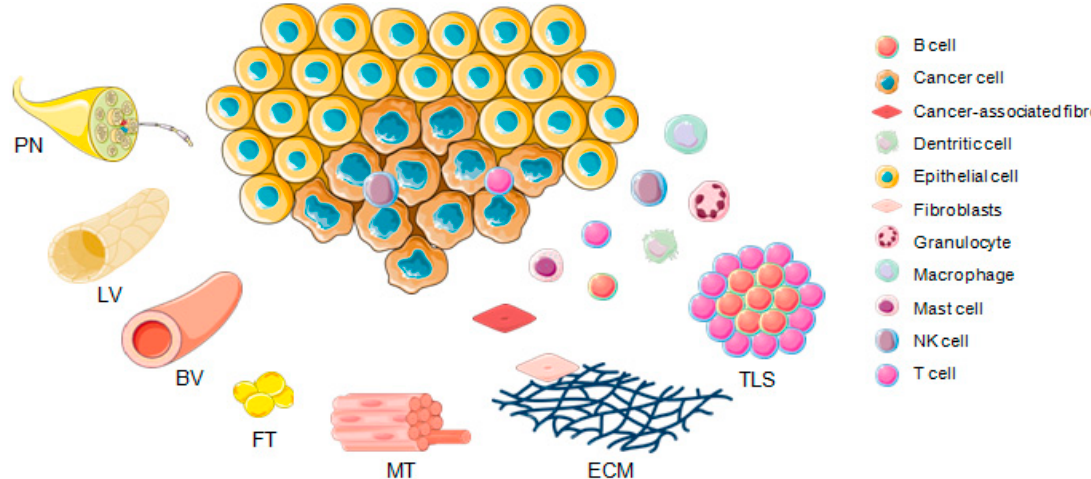
Figure 2. The tumor microenvironment. Structural components of the tumor microenvironment are blood (BV) and lymph vessel (LV), the extracellular matrix (ECM), adipose (AT) and muscle tissue (MT), peripheral nerves (PN), and tertiary lymphoid structures (TLS).